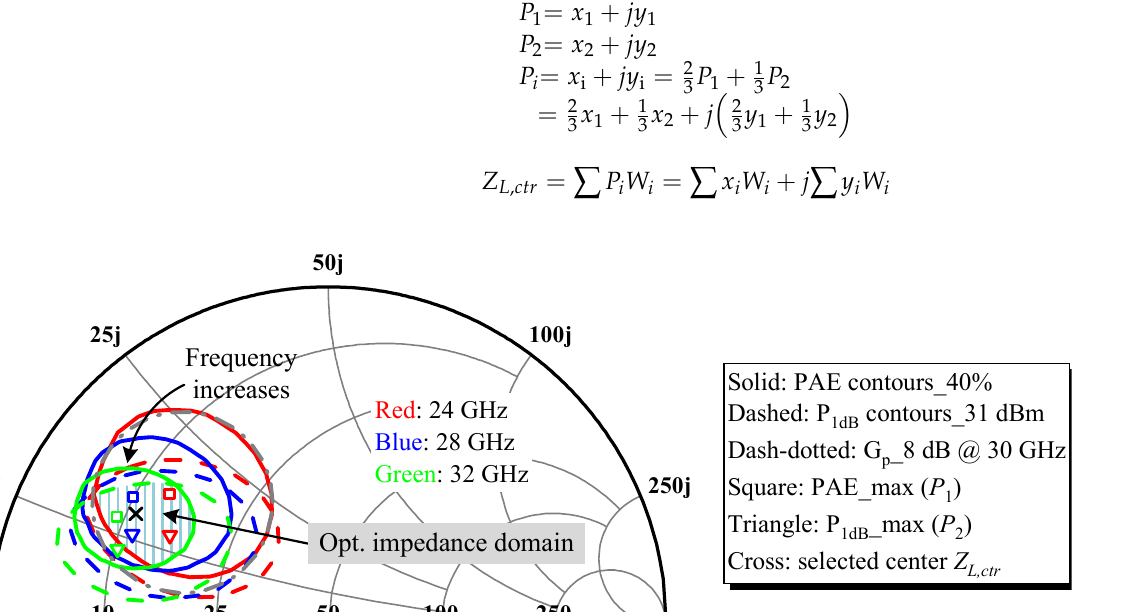
Table 2. Contour peaks and weighted averages at discrete frequencies.